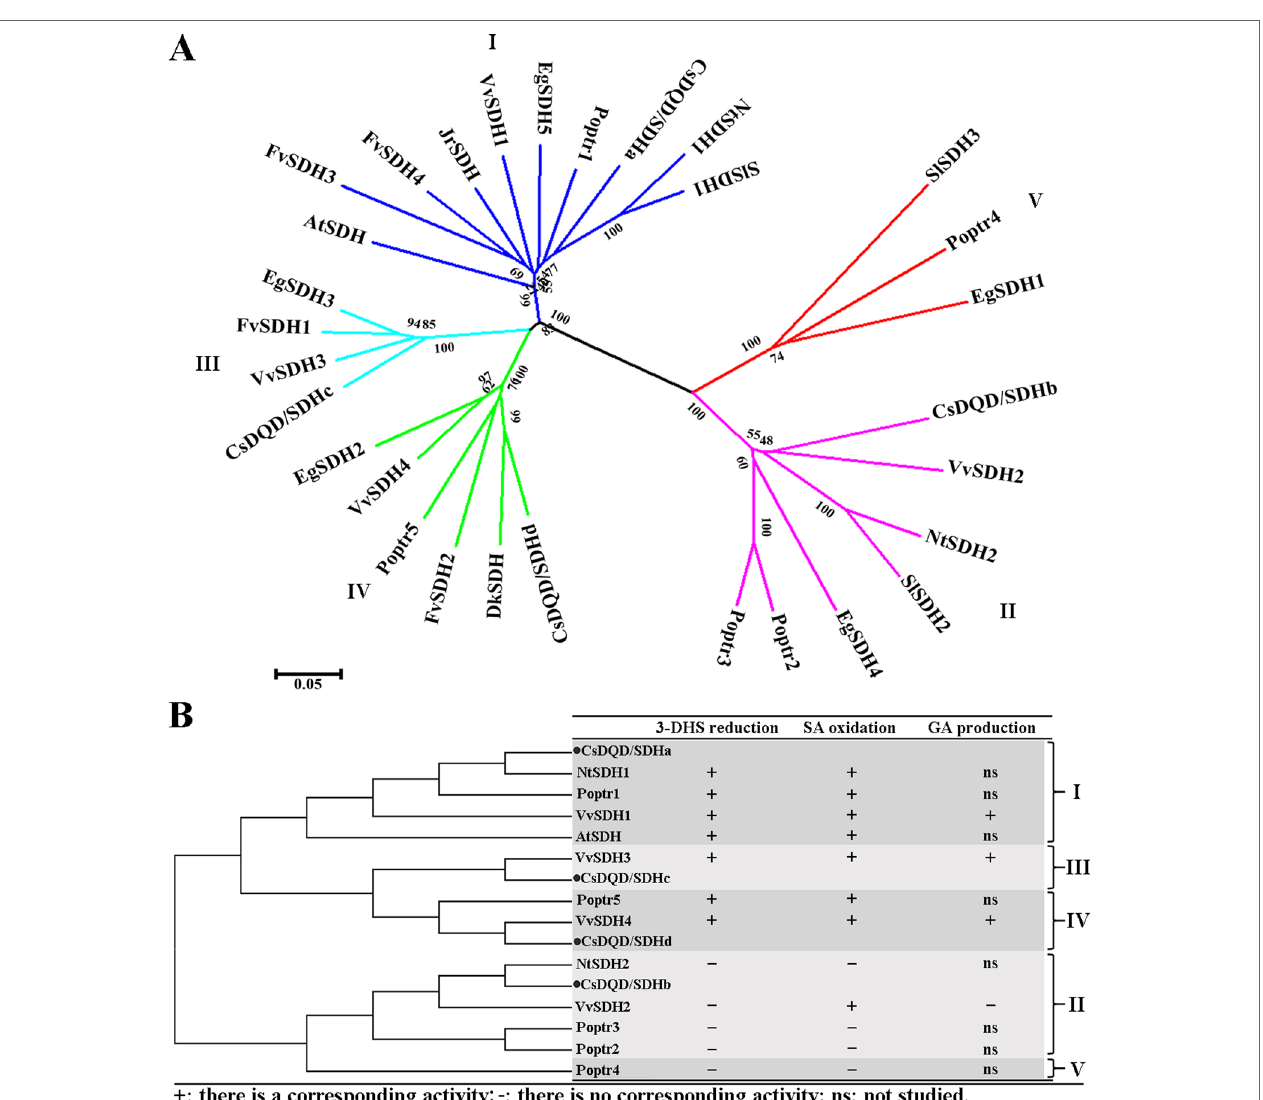
FIGURE 2 | Neighbor-joining tree analysis. (A) A neighbor-joining tree was constructed from the four Cs DQD/SDHs sequenced in this study and the 26 sequences available in public databases (NCBI and Phytozome 12) using MEGA 5.0 software. (B) A simplified neighbor-joining tree was constructed to display the enzyme characteristics of each DQD/SDH protein from Arabidopsis thaliana , Nicotiana tabacum , Vitis vinifera , and Populus trichocarpa . NCBI, National Center for Biotechnology Information; DQD/SDH, 3-dehydroquinate dehydratase/shikimate